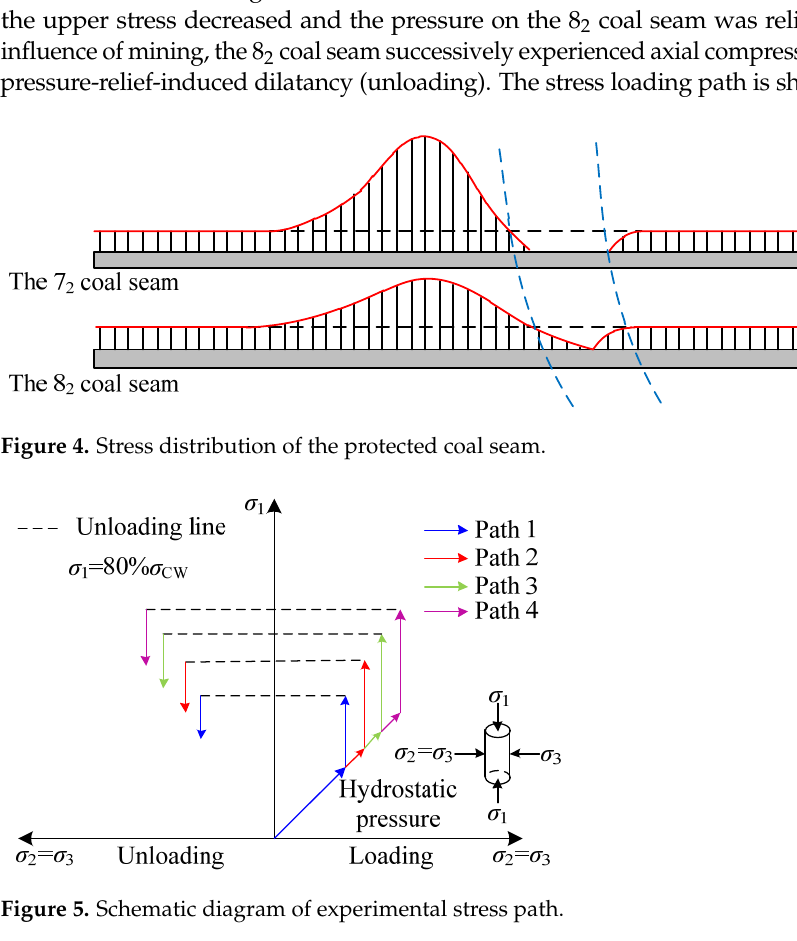
Table 3. Scheme for unloading experiments. Scheme No.